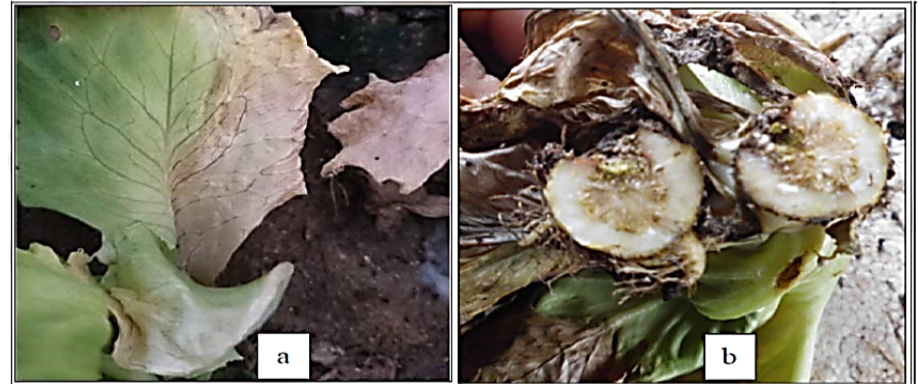
Figure 1. Symptoms of Fusarium wilting in lettuce under artificial infection symptoms on the margin of the outer leaves ( a ) and brown discoloration in the crown area ( b ). of the outer leaves ( a ) and brown discoloration in the crown area ( b